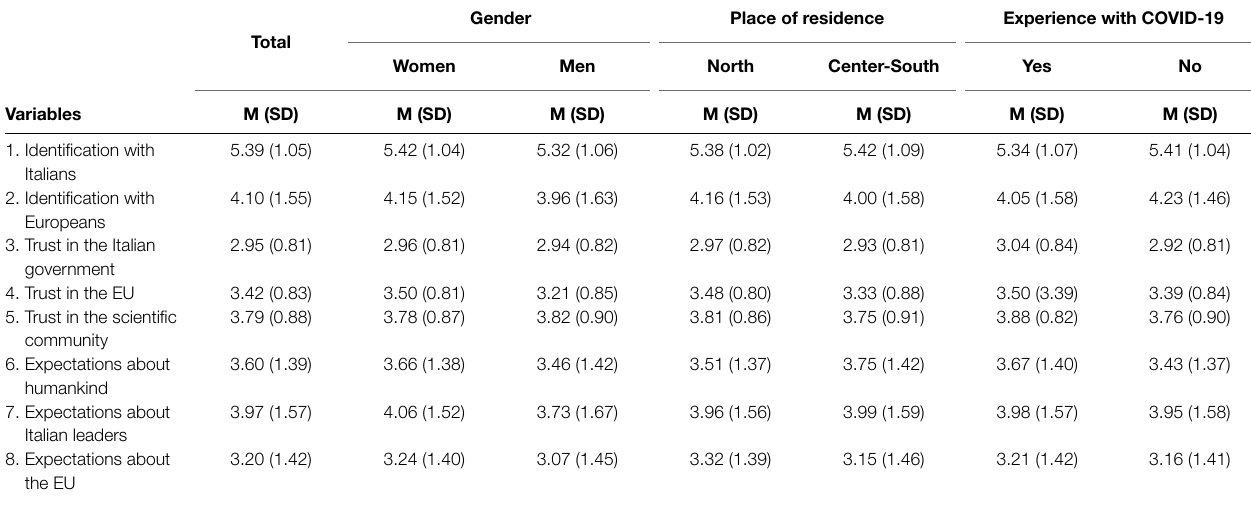
TABLE 1 | Descriptive statistics as a function of gender, place of residence, and experience with COVID-19 infection. Gender Place of residence Experience with Total